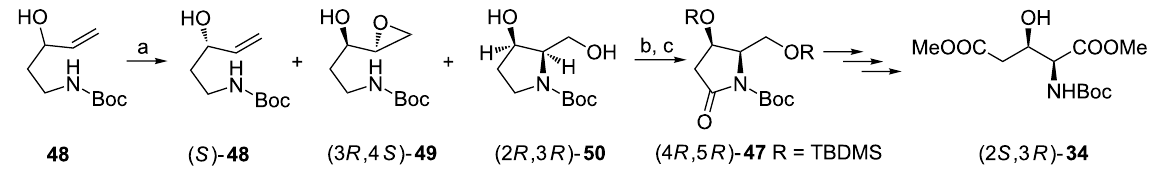
Scheme 12: Synthesis of N- Boc-protected dimethyl ester of (2 S ,3 R )- 2 via Sharpless epoxidation. Reagents and conditions: a) TBHP, D-( − )-DIPT, Ti(OiPr)